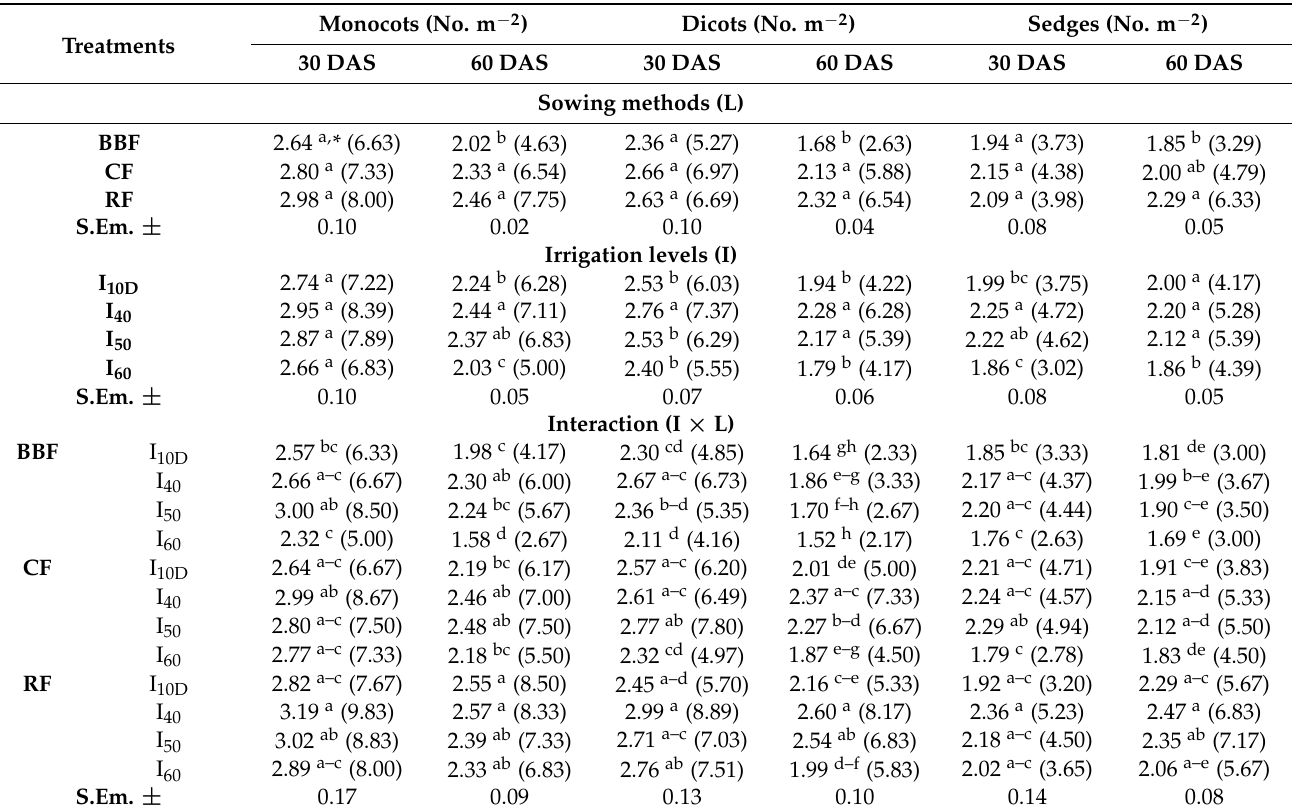
Table 3. Monocot, dicot and sedge density in maize as influenced by sowing methods and irrigation levels (pooled data of 2015 and